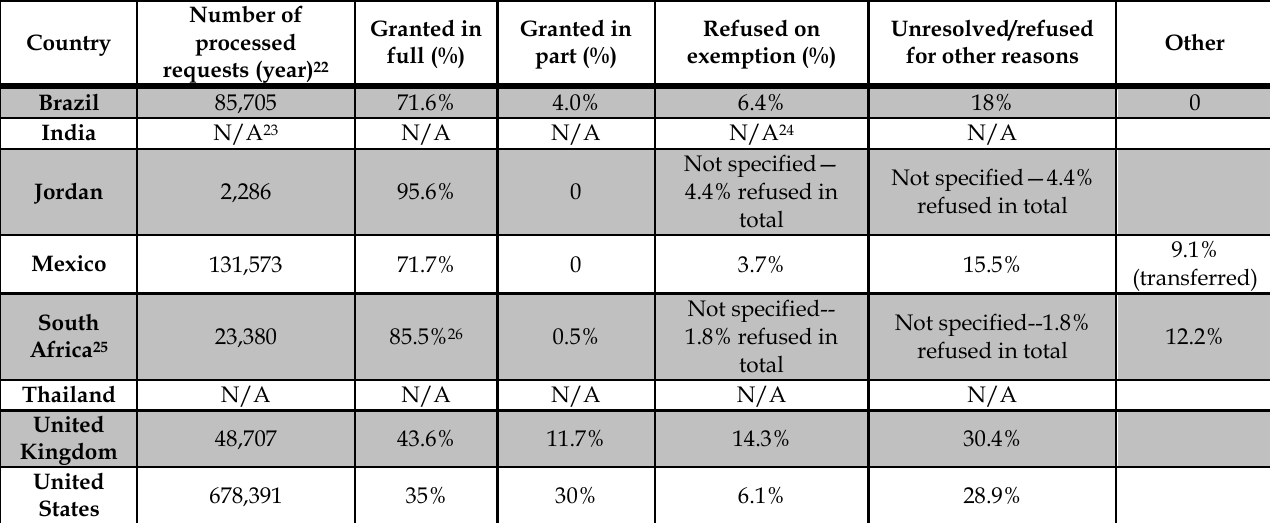
Table 3: Disposition (Response) to Processed